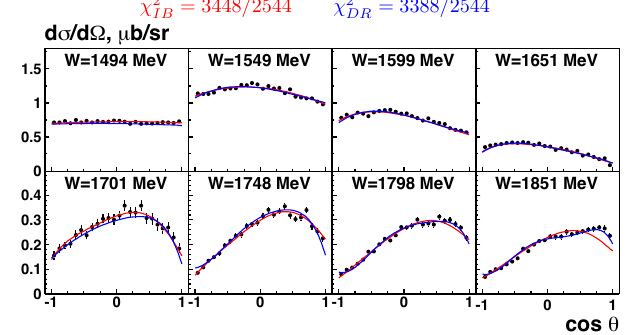
Figure 1. Isobar model (red curves) and dispersion relation (blue curves) fits compared to MAMI [25] di ff erential cross section data on η photo- production at eight values of W indicated in each panel as function of cos θ . Plot